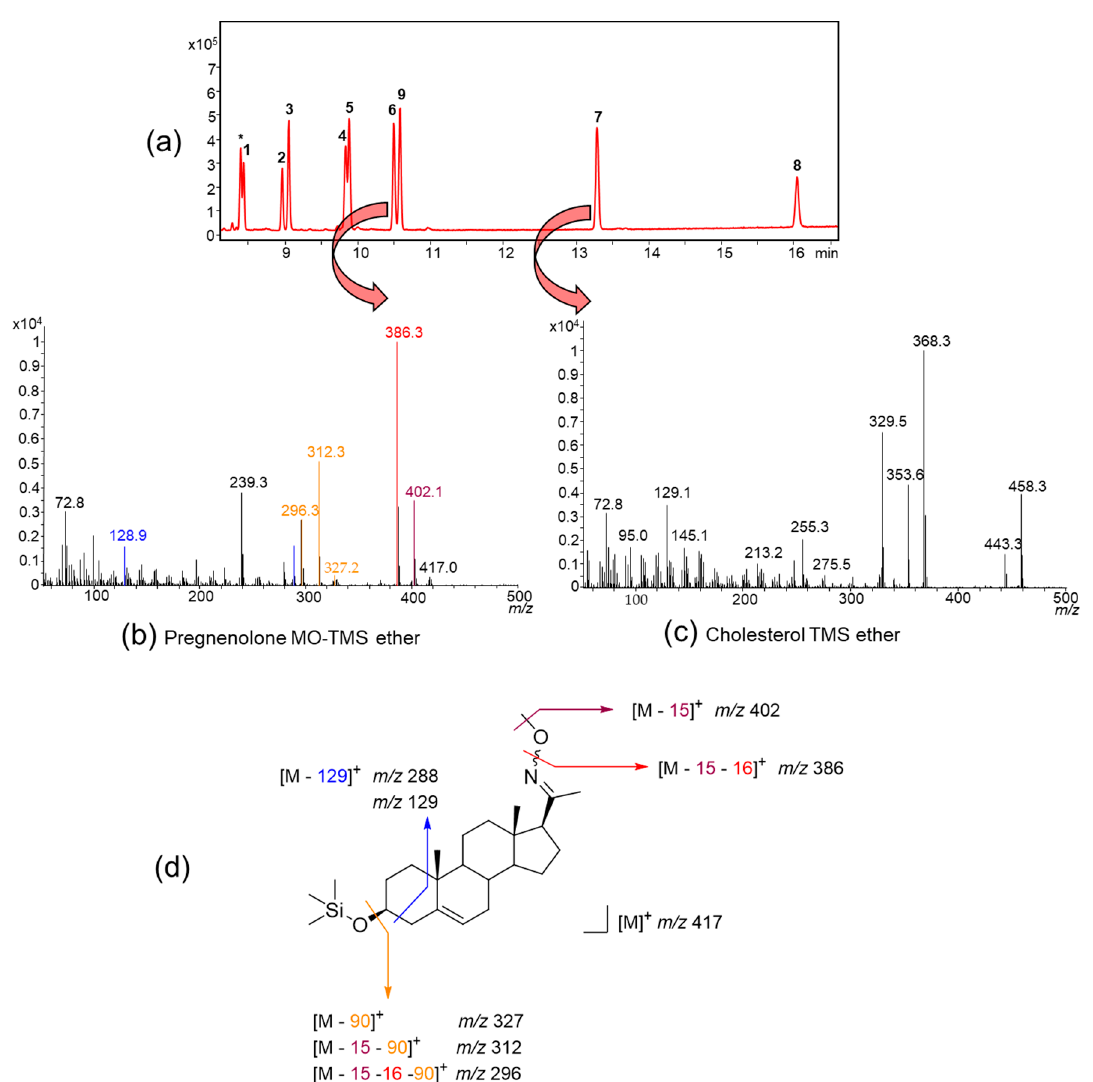
Figure 4. ( a ) Total ion chromatogram (TIC) of the eight sterol (MO-)TMS ethers and internal standard (IS). Analyzed sterols: 1 androsterone sulfate, 2 dehydroepiandrosterone sulfate, 3 epiandrosterone sulfate, 4 allopregnanolone sulfate, 5 pregnanolone sulfate, 6 pregnenolone sulfate, 7 cholesterol sulfate, 8 25-hydroxycholesterol sulfate, and 9 cholestane (IS). * Impurity of silylating reagent; ( b ) mass spectrum of pregnenolone MO-TMS ether; ( c ) mass spectrum of cholesterol-TMS ether; ( d ) proposed fragmentations of pregnenolone MO-TMS ether according to literature [29]. For chromatographic and mass spectral characteristics see Supplementary Table S1.